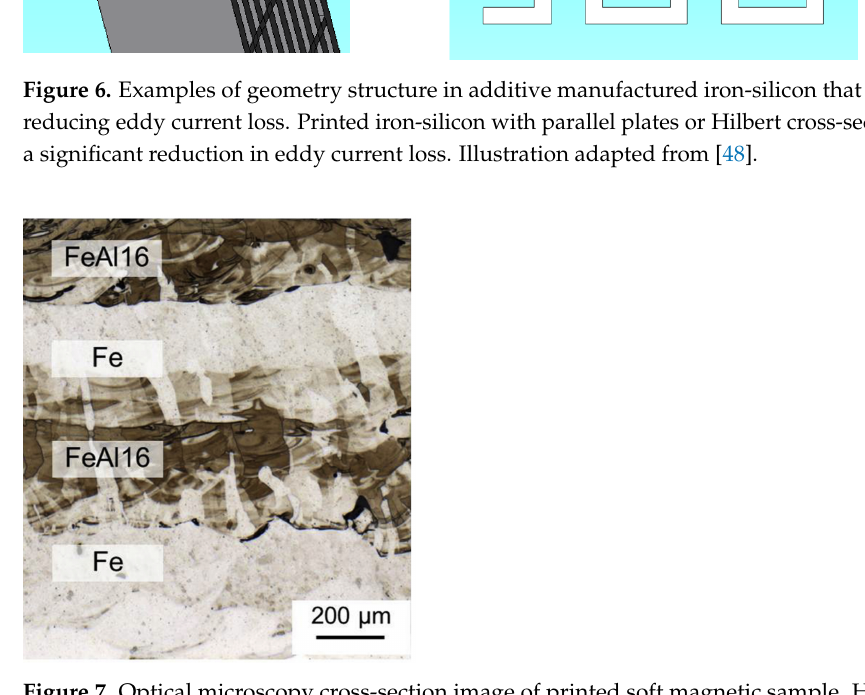
Figure 7. Optical microscopy cross-section image of printed soft magnetic sample. Here iron layer and iron-aluminum alloy layer are stacked back to back [45]. This printing strategy is implemented to reduce eddy current